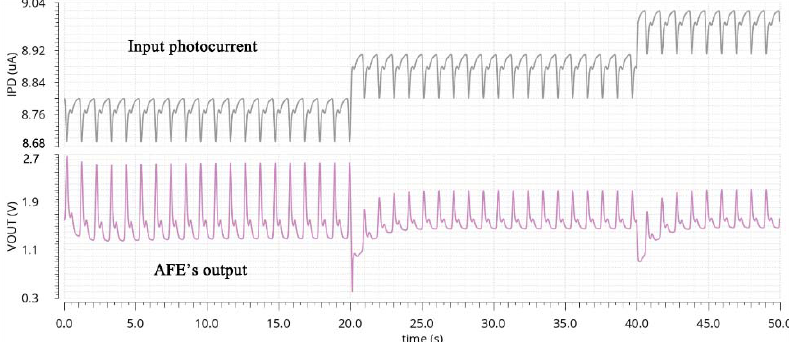
Figure 8. The transient response (simulation) of the final output as the DC component of I PD increases.